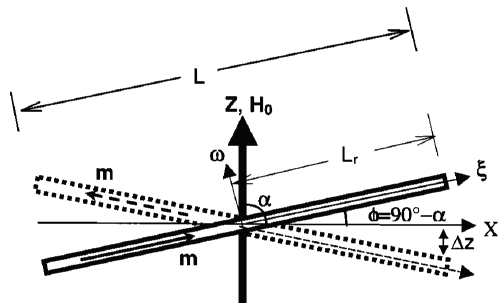
Figure 11. Scheme of the magnetic vectors in the device proposed by Ruan et al . [134], (cid:4652)(cid:4652)(cid:4652)(cid:4652)(cid:1318) is the bias magnetic field. Reprinted with where m (cid:4652)(cid:4652)(cid:1318) is the cantilever magnetisation and H 0 permission from [134]. Copyright 2001